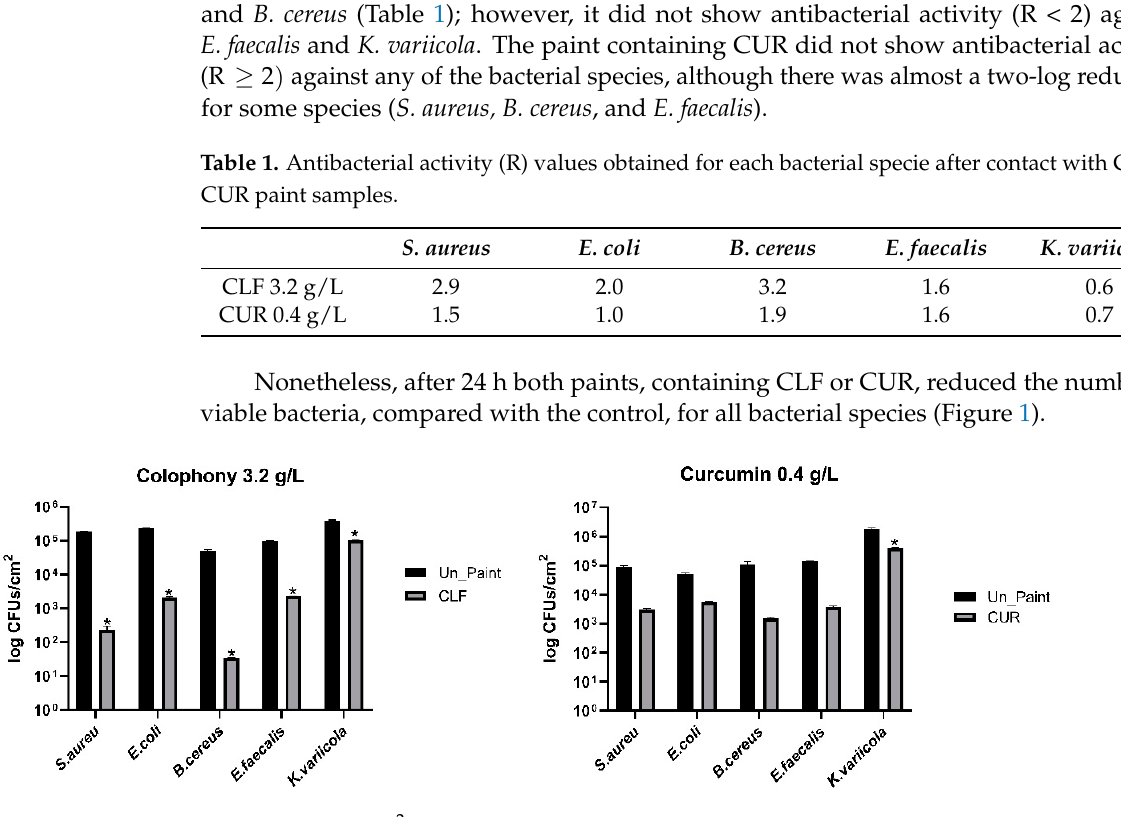
Figure 1. Average number of viable CFUs/cm 2 recovered from each paint sample after 24 h of contact. The values are Figure 2 presented in logarithmic scale. The values are expressed as mean ± standard deviation. The statistical significance of samples (CLF/CUR) compared with Un_Paint is represented by *. (Two-way ANOVA; p <